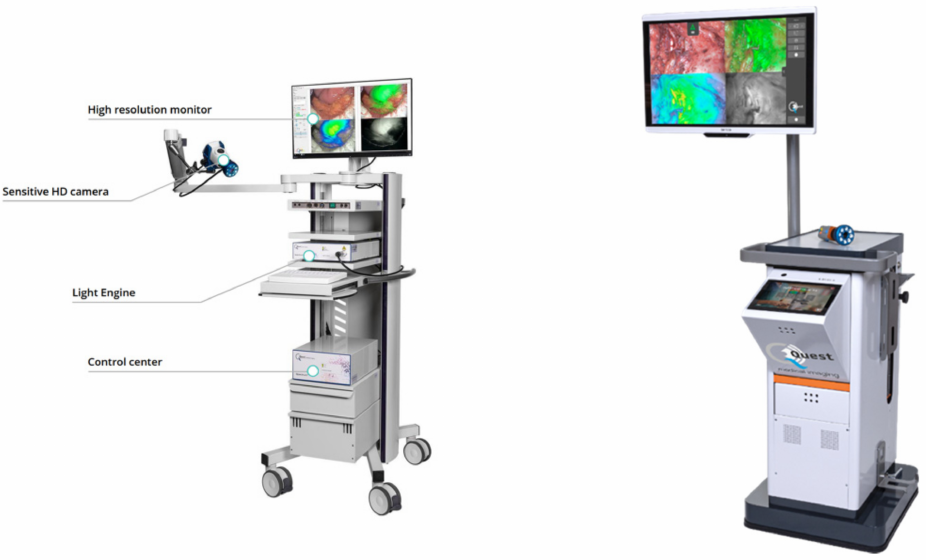
Figure 14. The Quest Medical Imaging fluorescence image guided surgery devices, Quest Spectrum ® 2.0 ( left ) and Quest Spectrum ® 3.0 ( right ) used in our approach. Due to the unique combination of the filters in the camera and the wavelengths of the lasers in the light source, the system can detect low amounts of fluorescence in the tissue and show the tissue viability by analysing the perfusion characteristics of the intravenously injected ICG (Figure